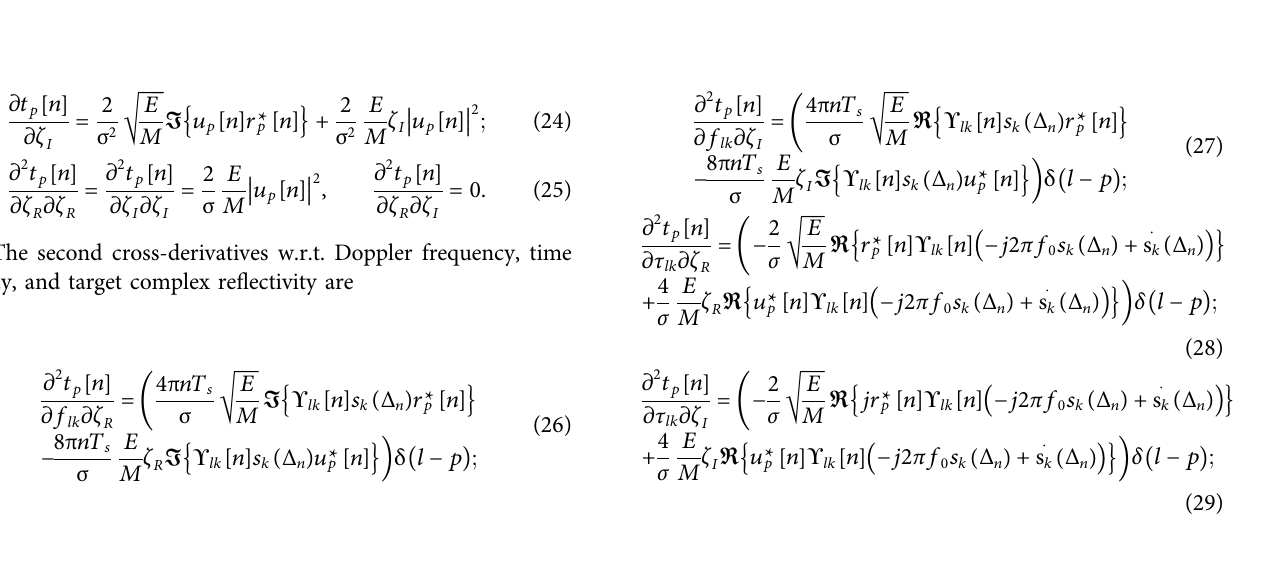
Frontiers in Signal Processing |